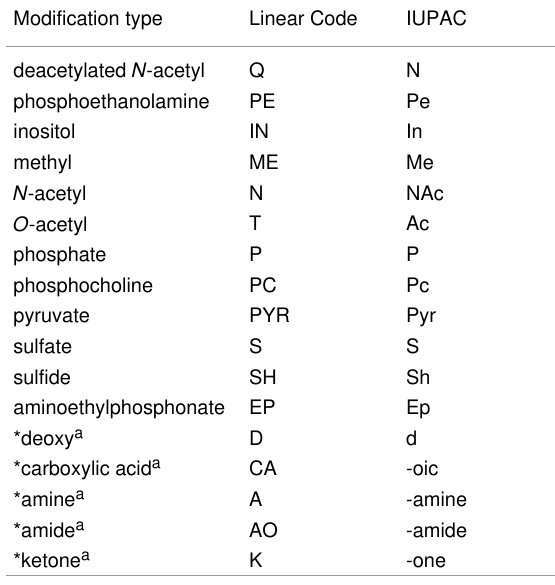
a Asterisk (“*”) represents an update from the original